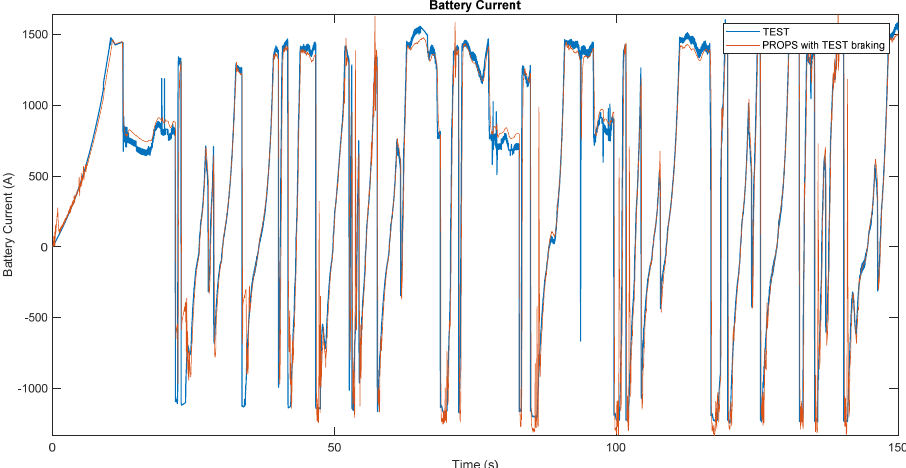
Figure 24. TEST (in blue) and PROPS (in red) battery current (in Ampere) vs. Lap Time (in seconds).